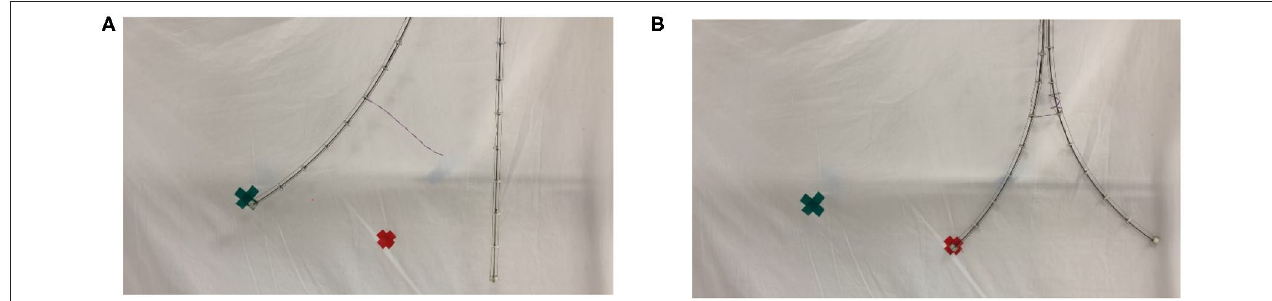
FIGURE 13 | (A) Unconstrained left searcher reached the green (left) cross marker, but not reaching the red (right) cross marker. (B) Braided searcher pair, using antagonistic actuation, creates a smaller bending radius, enabling the left searcher to reach the red cross